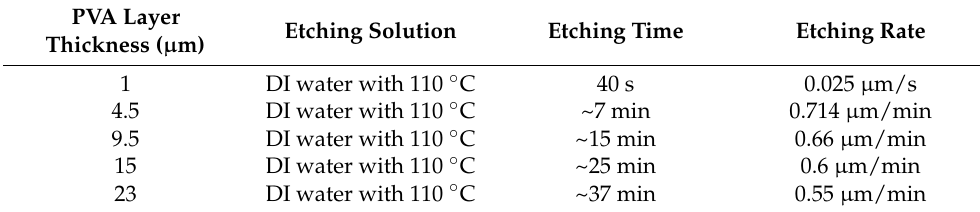
Table 7. Etching rate for PVA layers of different thicknesses.